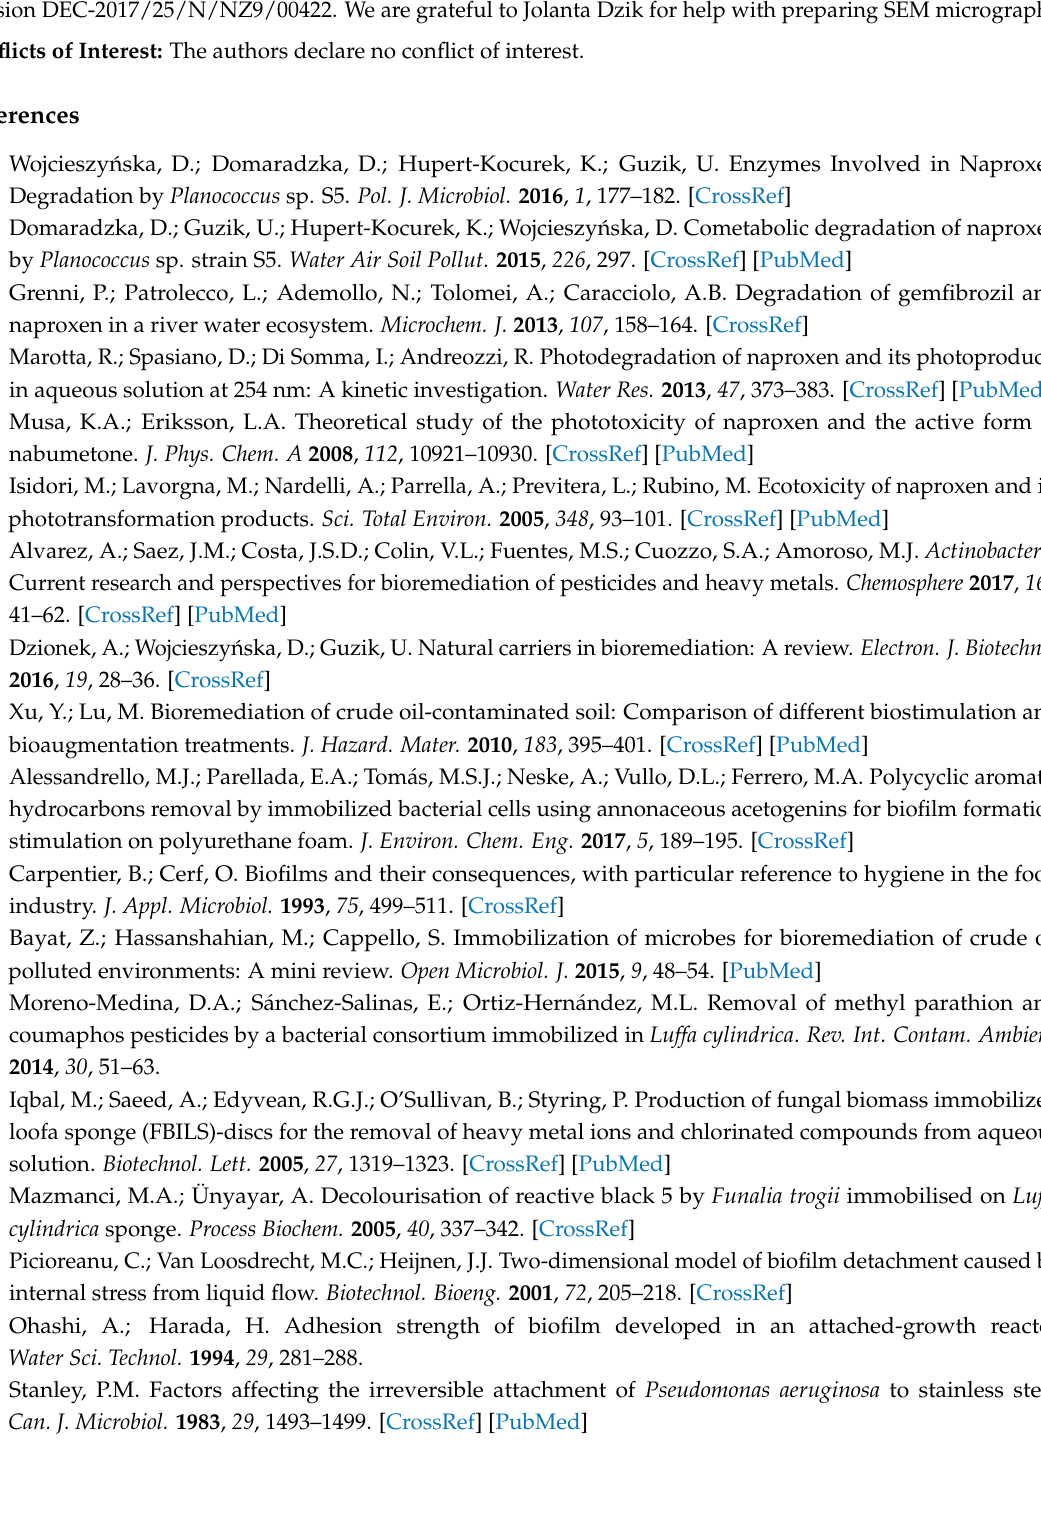
Figure S1: Effect of various environmental and physiological factors on the efficiency of Planococcus sp. S5 cells immobilization onto the loofah